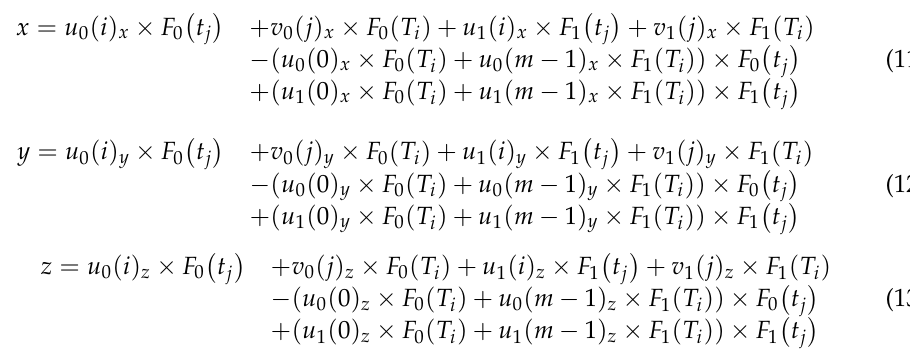
Figure 9. Schematic diagram of the Coons surface interpolation. Based on Equation (9), the x , y , and z of each vertex can be calculated respectively by harmonic function, according to the coordinates of four corners and four relevant points, as well as the t of the four relevant points. Because the synchronous forward method is adopted, the t values of the opposite sides are the